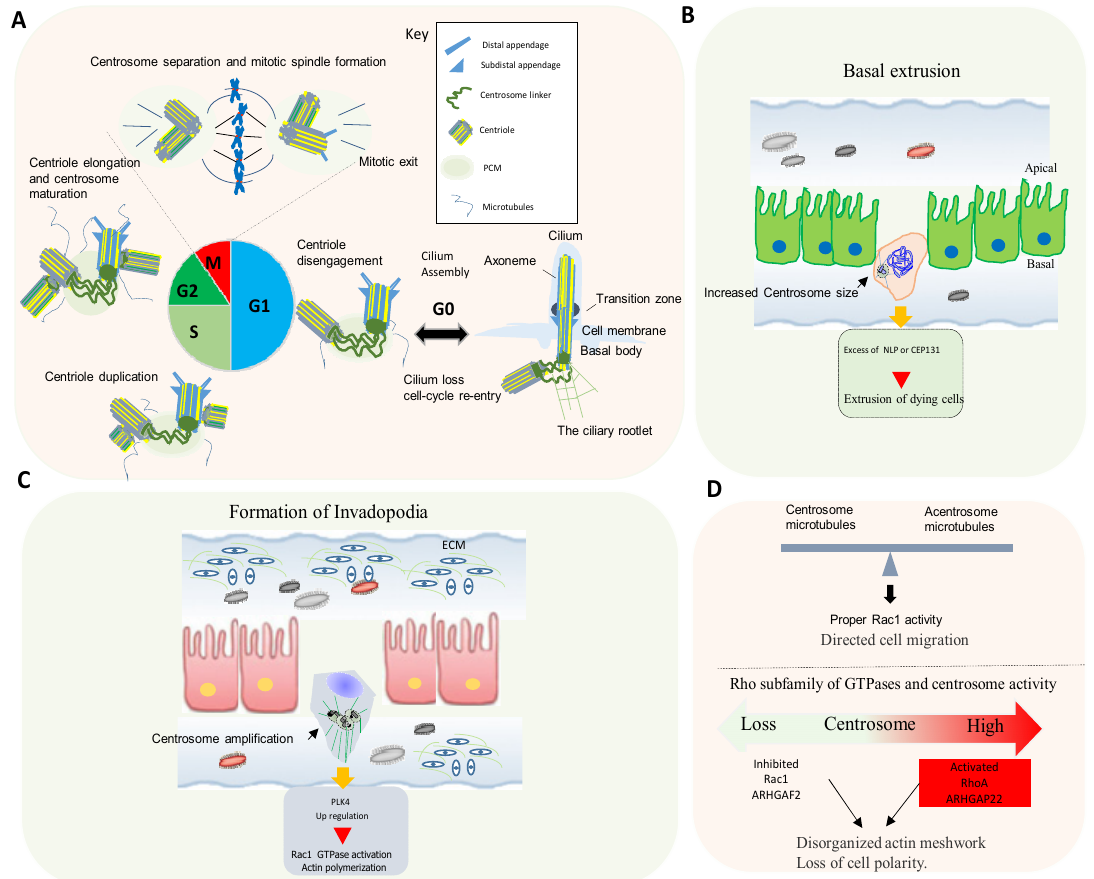
Figure 2. Centrosome cycle and its role in cell motility and invasion. ( A ) In dividing cells, the centrosome duplicates once per cell cycle and segregates in concert with cell-division cycle. The centrosome number and structure are highly regulated during each cell cycle to organize an effective bipolar spindle in the mitotic phase. At the end of mitosis, the daughter centriole disengages from the mother centriole and a centrosome linker is established. When cells enter G0 phase, centrioles can become basal bodies that organize the primary cilium. Shared pathways ensure the coordination between centrosome dynamics, chromosome replication–segregation cycles, and ciliogenesis. Details on the centrosome/cilia dynamins can be found in recent excellent reviews [8,21,23,26,27]. ( B ) Excess of expression of centrosome genes (structural changes) can disrupt apical cell extrusion, instead, causing aberrant basal extrusion. ( C ) Centrosome amplification triggered by overexpression of Plk4 induces the formation of invasive protrusions (invadopodia), which are accompanied by the degradation of ECM components. The increase in centrosomal microtubule nucleation in cells with extra centrosomes promotes activation of the small GTPase Rac1. Rac1 activity, in turn, initiates actin polymerization that disrupt cell-cell adhesion and promotes cell migration. ( D ) Up, the centrosome acts as a controller and balances the formation of centrosomal and acentrosomal microtubules. The presence of centrosome regulates proper Rac1 activity and allows directed cell migration. Down, centrosome activity (loss or activation) regulates differently members of Rho family of GTPases family. Interference or an excess with the formation of centrosome increases acentrosome, microtubules assembly, and activation of Rac1, which in turn leads to the loss of cell